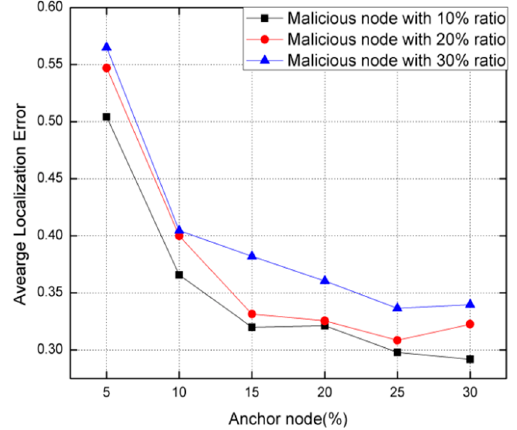
Figure 8. Localization error versus anchor node ratio under the malicious.